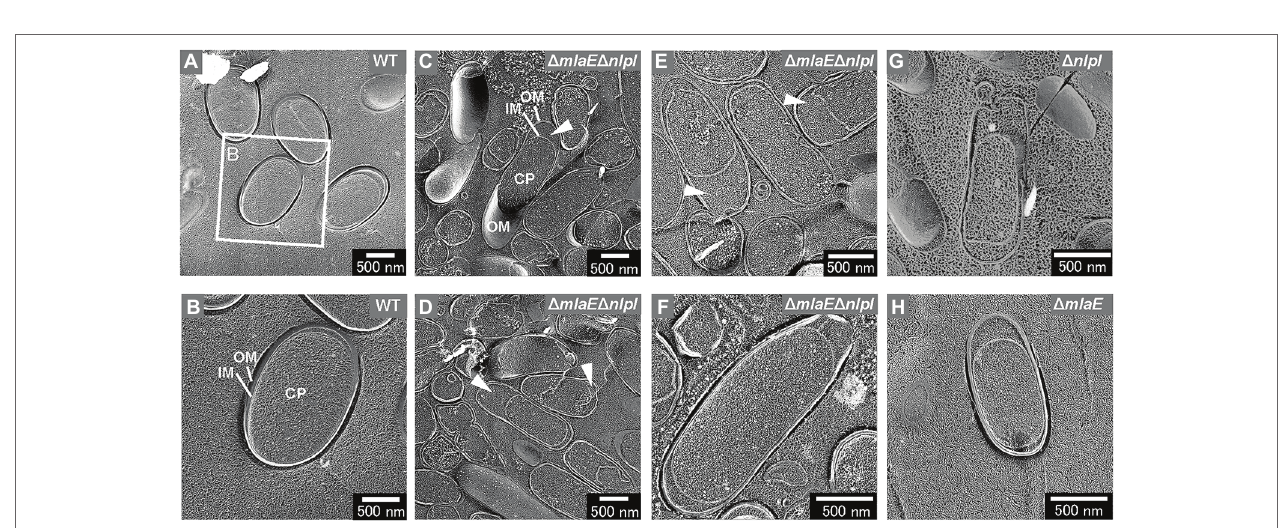
FIGURE 3 | Cross-section of various fractured E. coli cells visualized by QFDE-EM. (A) Field image of cells. (B) Magnified image of the structure of the WT cells. (C) Field image of the Δ mlaE Δ nlpI cells. OM, outer membrane; IM, inner membrane; and CP, cytoplasm. (D–F) Magnified image of the structure of the Δ mlaE Δ nlpI cells. The arrowheads indicate the plasmolysis. (G) Magnified image of the structure of the Δ nlpI cells. (H) Magnified image of the structure of the Δ mlaE